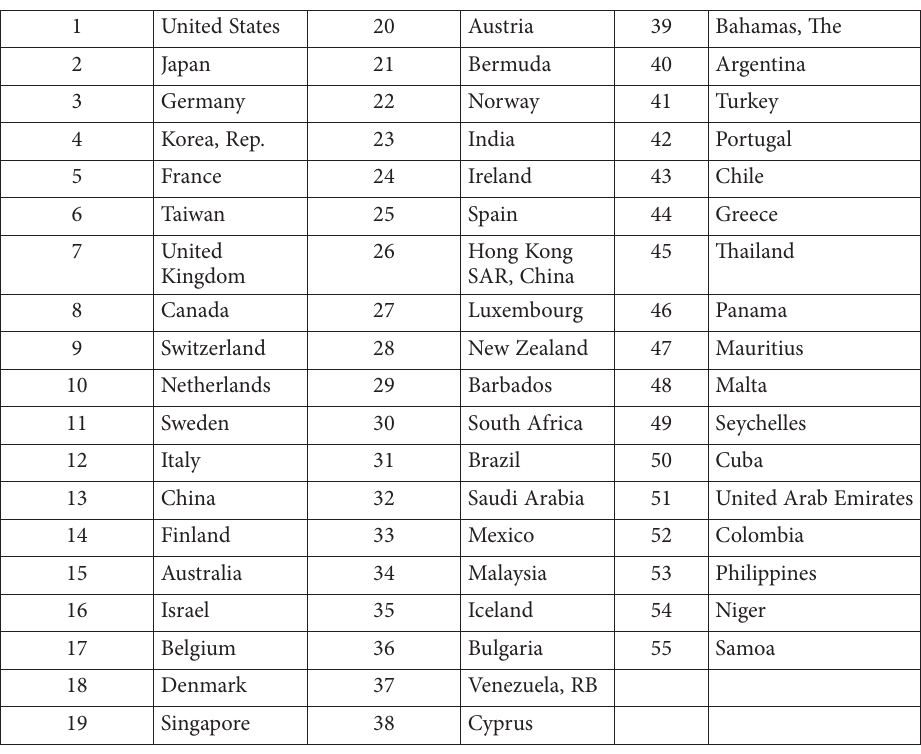
Table A.1. Countries investigated in this study